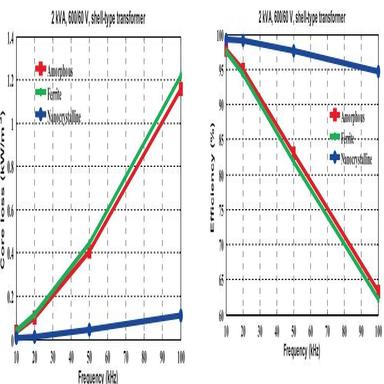
2 kVA, 20 kHz, 600/60 V, shell-type transformer. (a) Core loss (kW/m3 ) versus frequency (kHz); (b) Efficiency (%) versus frequency (kHz).